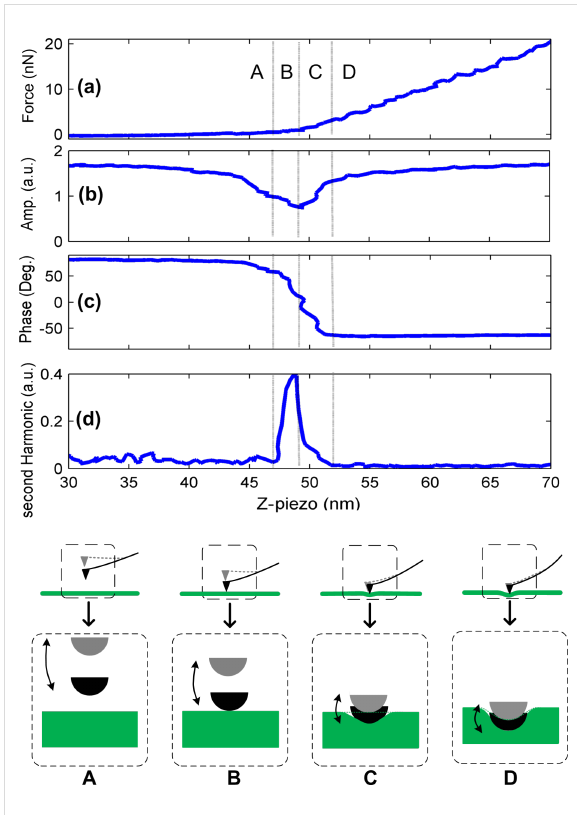
Figure 2: (a) Force, (b) first-harmonic amplitude, (c) first-harmonic phase, and (d) second-harmonic amplitude, plotted as a function of Z-piezo displacement. As the probe approaches the gold sample surface, the cantilever encounters four regimes: (A) free oscillation, (B) partial contact, (C) soft contact, and (D) hard contact. To highlight the differences in cantilever bending and the level of indentation in the four regimes, the schematic is not drawn to